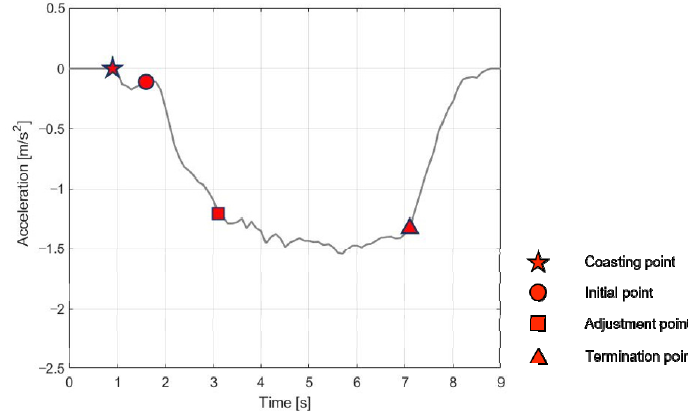
Figure 3. Deceleration profile in general car-following.